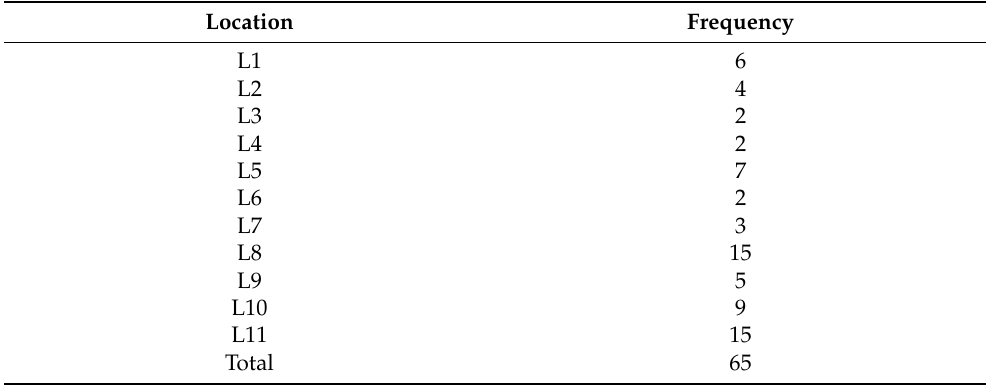
Table 4. Frequency of images captured at each location